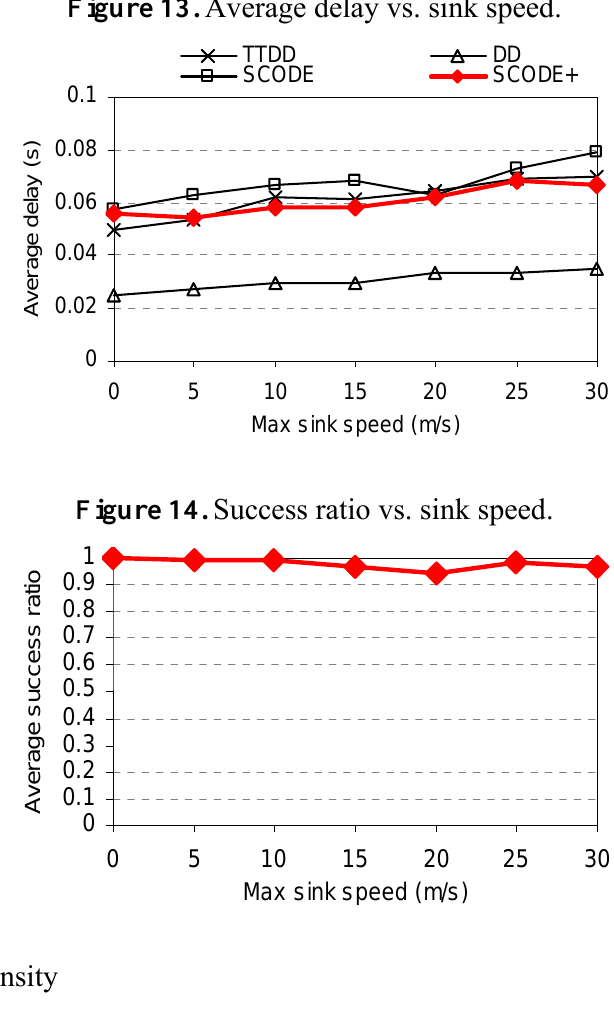
Figure 13. Average delay vs. sink speed.